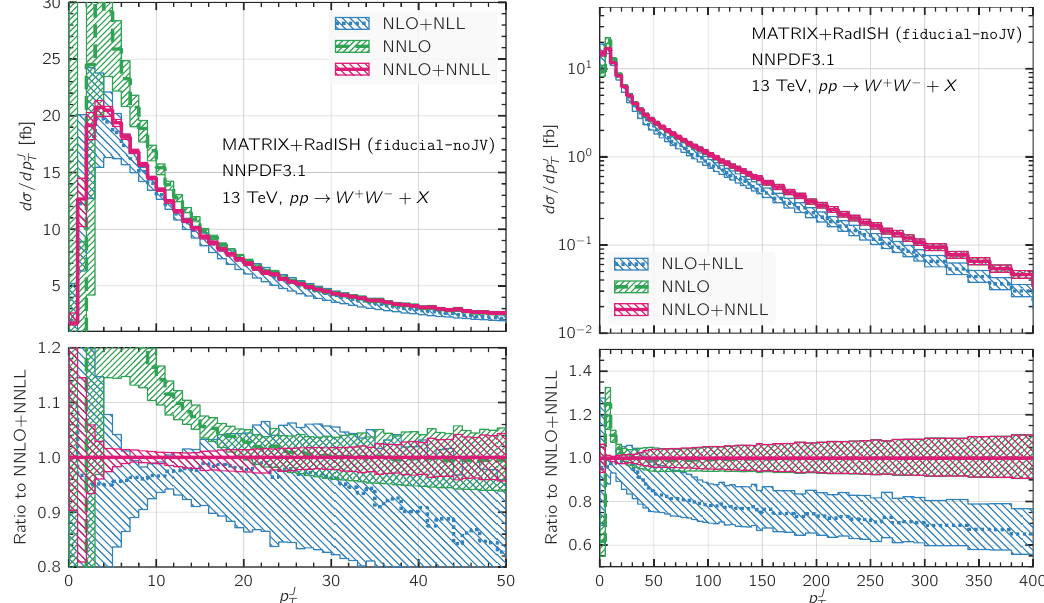
Figure 4 . Transverse-momentum spectrum of the leading jet in the fiducial-noJV phase space at NLO+NLL (blue, dotted), NNLO (green, dashed), and NNLO+NNLL (magenta, solid) accuracy. Left plot: spectrum up to 50 GeV. Right plot: spectrum up to 200 GeV. The lower frames show the ratios of the predictions to the central value of our best prediction at NNLO+NNLL.